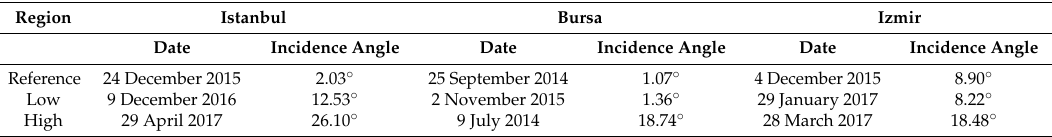
Figure 1. Study sites and overview of the images used in this research: ( a ) Geographic distribution of the study regions (Google Earth©). ( b ) Overview of the Istanbul region. ( c ) Overview of the Bursa region. ( d ) Overview of the Izmir region. Table 1. Specifications of the satellite images used in this study.